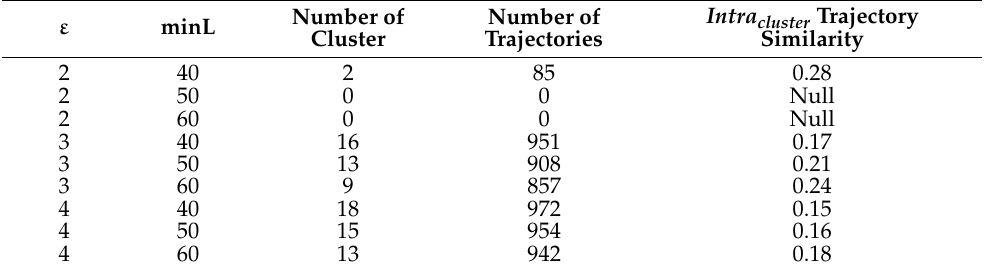
Table 9. Intra-cluster trajectory similarity results for different parameter